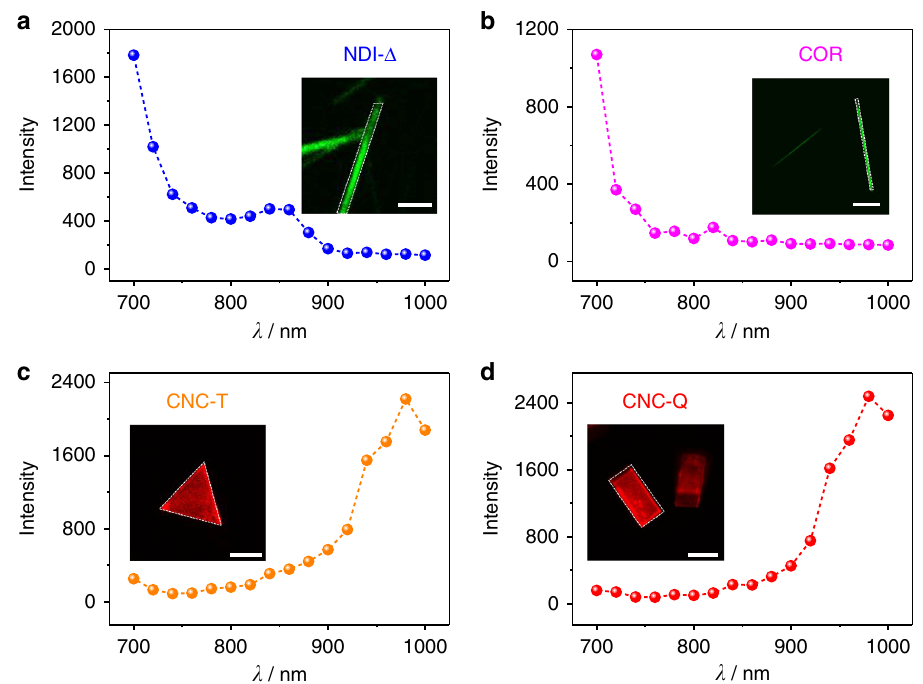
Fig. 8 Excitation wavelength dependence of upconversion fl uorescence intensity. Two-photon excited spectra of a NDI- Δ , b COR , c CNC-T and d CNC-Q . The laser powers corresponding to the spectra were set to be 13.3, 2.7, 2.7, and 2.7 mW, respectively. The upconversion fl uorescence intensity of each material was collected from the marked region in the inset two-photon microscopy image. Scale bars: 10 μ m in ( a ), 100 μ m in ( b ), 20 μ m in ( c , d